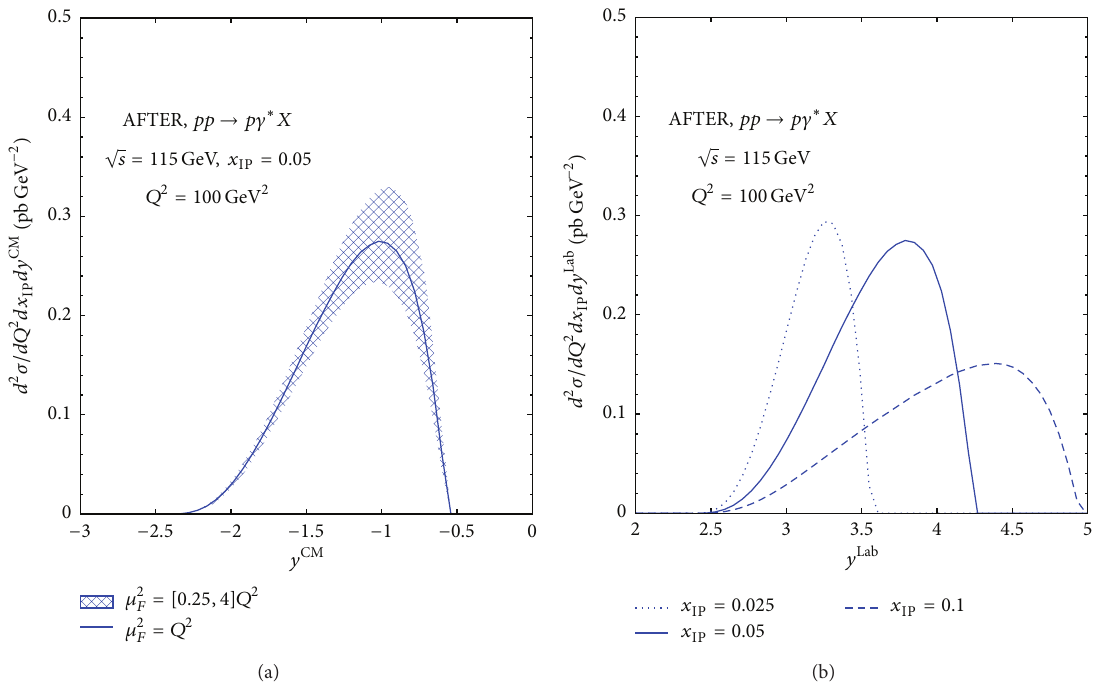
= 0 . 05 and of mass 𝑄 2 = 100 GeV 2 . Blue error IP